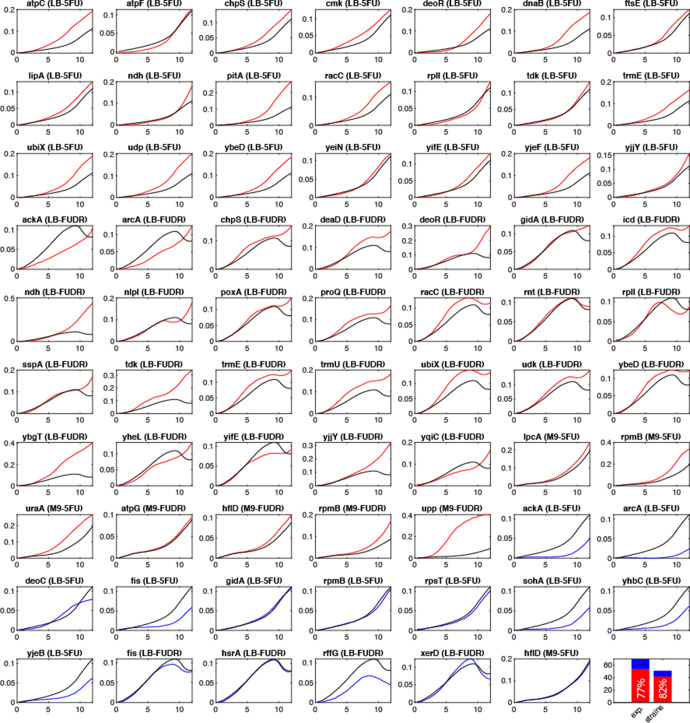
Drug resistance of individual knockout strains.We monitored the growth of the wild-type strain and 50 individual knockout strains in 69 different growth conditions (each strain was tested in the pooled genetic screen condition it was found in). The graphs show the mean growth curve for replicate cultures (duplicates for knockout strains and 10 replicates for the wild-type strain). To allow comparison with the wild-type strains, we only tested hit strains that are not slow growing strains in the tested media (without drug) and are not annotated as auxotrophs in the EcoCyc database. A knockout strain was considered a hit if its absorbance in the last time point was higher than that of the wild-type strain (red curves). A strain was counted as a non-validated strain if its absorbance in the last time point was equal or lower than the wild type. The lower right bar graph shows the percentage of validated hits (by the 69 growth conditions or by the 50 tested strains).